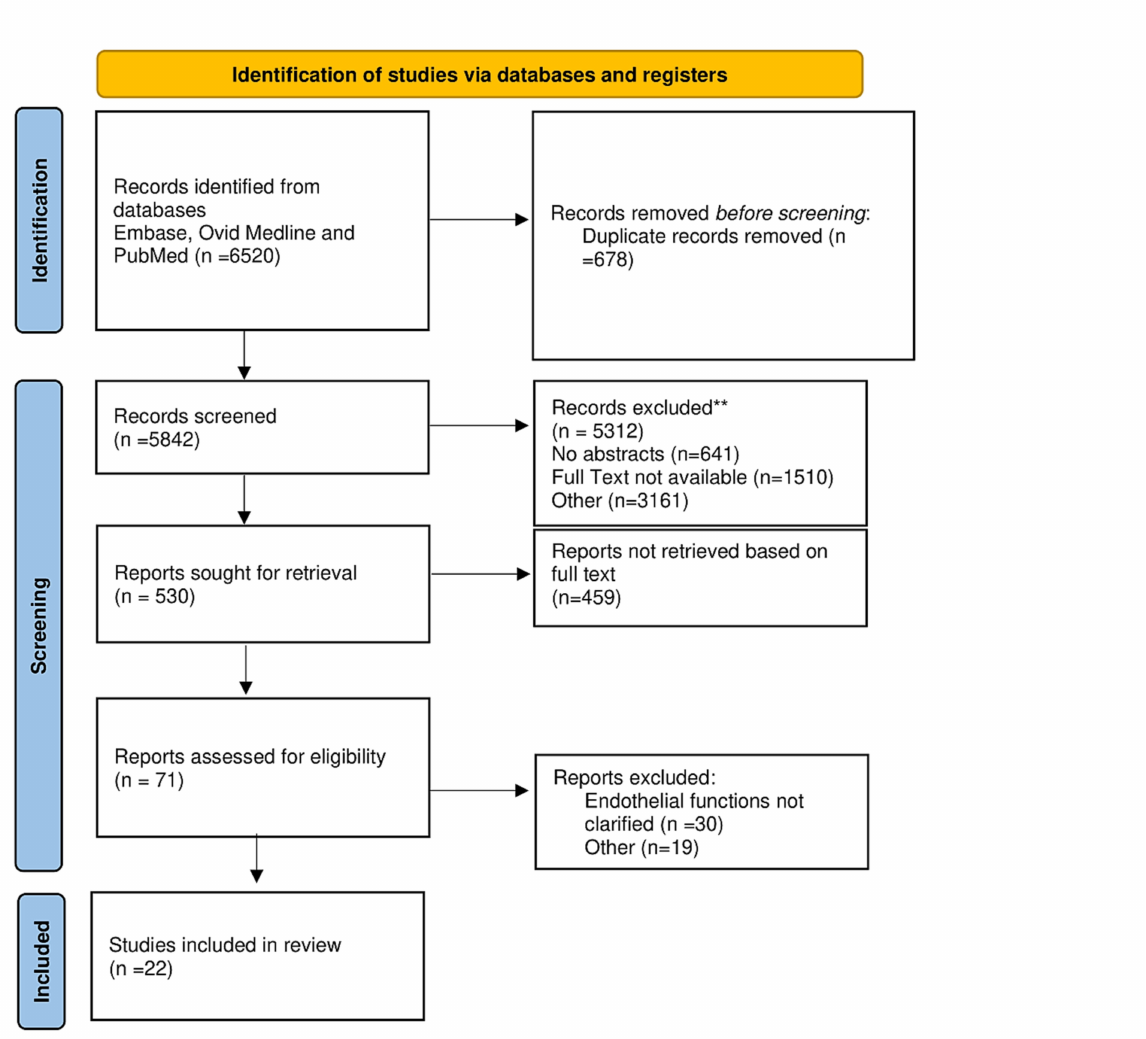
Figure 1. PRISMA flow diagram. For more information, visit: http://www.prisma-statement.org/ (accessed on 1 November 2022) ** Manuscripts that did not meet the criteria